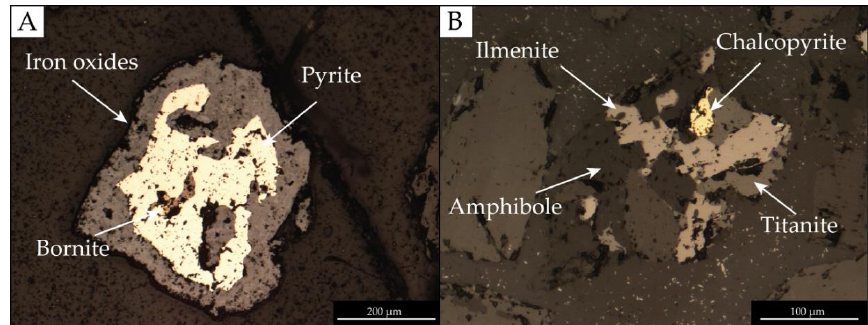
Figure 3. ( A ) The heavy minerals fraction from sample JP 08 (fraction < 0.1 mm); ( B ) the heavy minerals minerals fraction from sample JP 07 (fraction < 0.25 mm). SEM-BSE images. fraction from sample JP 07 (fraction < 0.25 mm). SEM-BSE images.